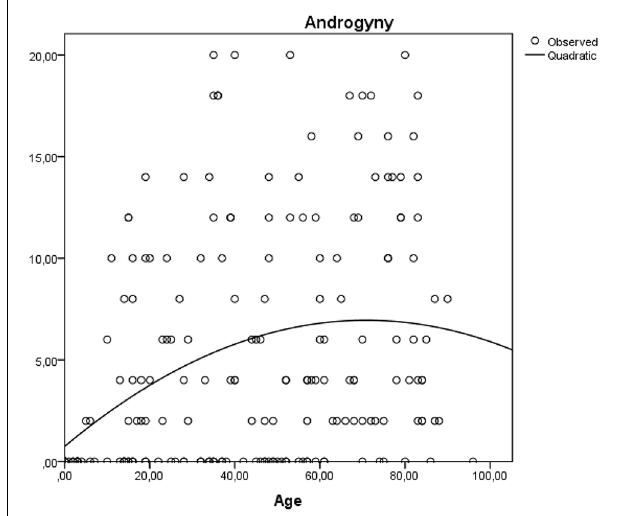
FIGURE 7 | The non-linear association between age and